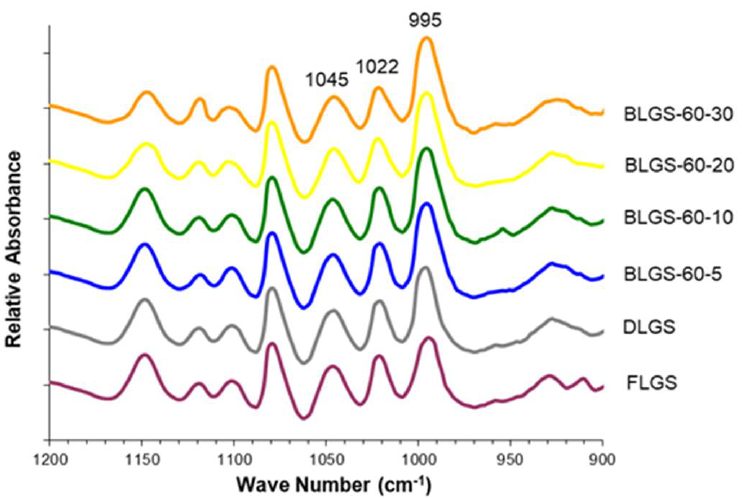
2.6. Attenuated Total Reflectance Fourier-Transform Infrared Spectroscopy (ATR-FTIR)